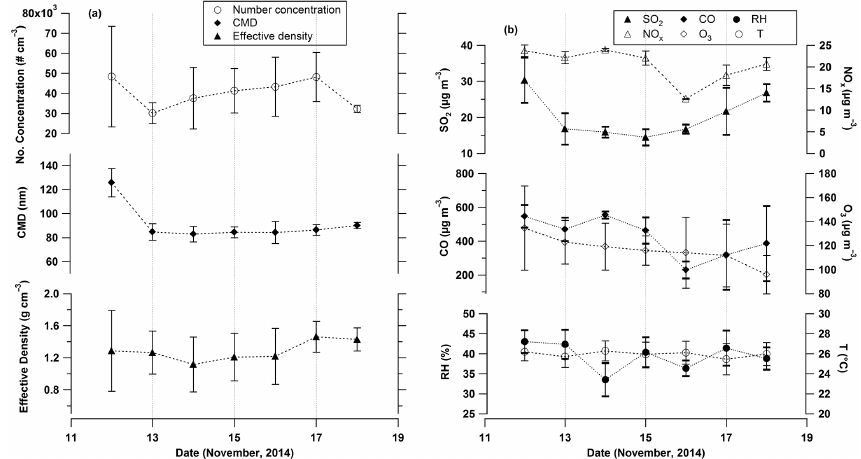
Figure 4. Mid-day (10:00–13:00LT) mean (bar represents standard deviation) of (a) number concentration, count mean diameter (CMD), effective density, and (b) relative humidity, temperature and gas concentrations (CO, O 3 , SO 2 , NO x ) .